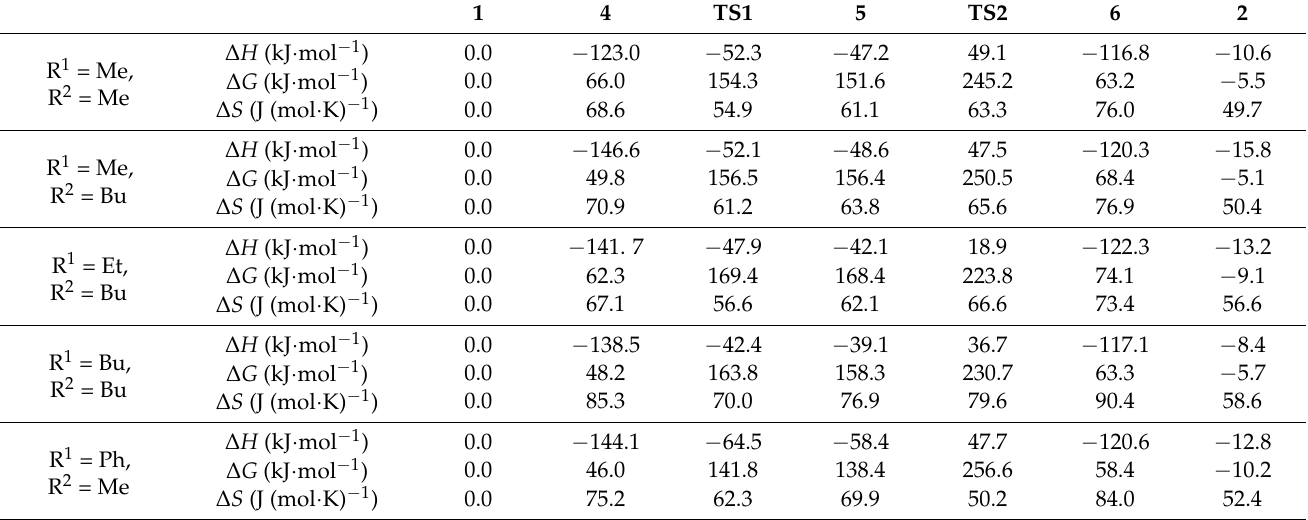
Table 5. Energetics for the monoesterification of alkylphosphonic acids ( 1 ) obtained by DFT computations at the M062X/6–311+G (d,p) level of theory considering the solvent effect of the corresponding alcohol.